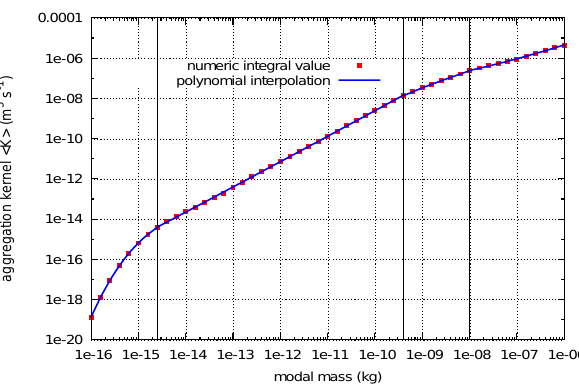
Fig. 1. h K i integral values (in m 3 s − 1 ) as a function of the modal mass (in kg) of the crystal mass distribution and for σ m = 2 . 85. The corresponding sizes range between a modal length of 0.6 and 8000µm. Exact values from a numerical integration are shown as squares. The solid lines represent polynomial fits in 4 different mass ranges, indicated by the black lines.